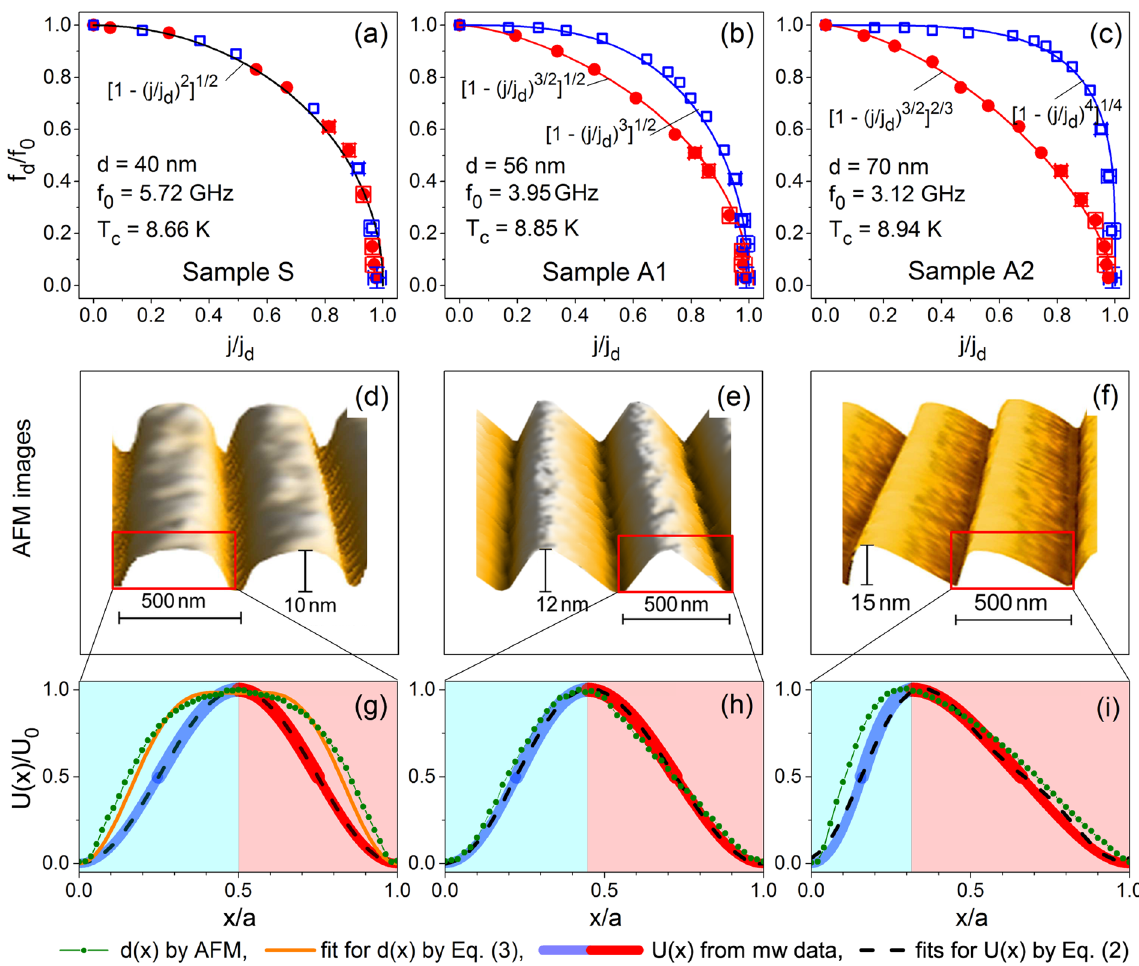
Figure 6. ( a – c ) Reduction of the depinning frequency upon increasing the dc density as deduced from the mw power absorption data. The experimental data for the positive ( ● ) and the negative ( □ ) dc polarity are approximated by fits (solid lines of respective color) of the general form f d / f 0 = [1 − ( j / j d ) k / l ] m / n , with the exponents k , l , m , n as indicated. ( d – f ) Atomic force microscope images of the WPP landscapes milled by FIB on the surface of samples S, A1, and A2. When subjected to a combination of microwave and dc currents, fluxons act as movable coherent “sensors” probing the curvature of U ( x ): The ac component shakes the fluxons in the vicinity of their equilibrium points which are unequivocally determined by the local pinning force counterbalanced by the driving (Lorentz) force induced by the dc bias current. A positive dc bias makes the vortices to “probe” the gentle groove slope, whereas the steep groove slope is probed by vortices when they are subject to a negative dc bias. ( g – i ) The coordinate dependences of the pinning potentials U ( x ) deduced numerically using the approach outlined in Supplementary (solid lines) are plotted together with fits (dashed lines) to Eq. (2) and the cross-sectional AFM line scans across the grooves (symbols). The light red areas in panels (g–i) correspond to the left-hand WPP groove slopes in panels (a–c) probed at positive dc bias values (red solid symbols in panels (a–c)). The light blue areas in panels (g–i) correspond to the right-hand WPP groove slopes in panels (a–c) probed at negative dc bias values (blue open symbols in panels